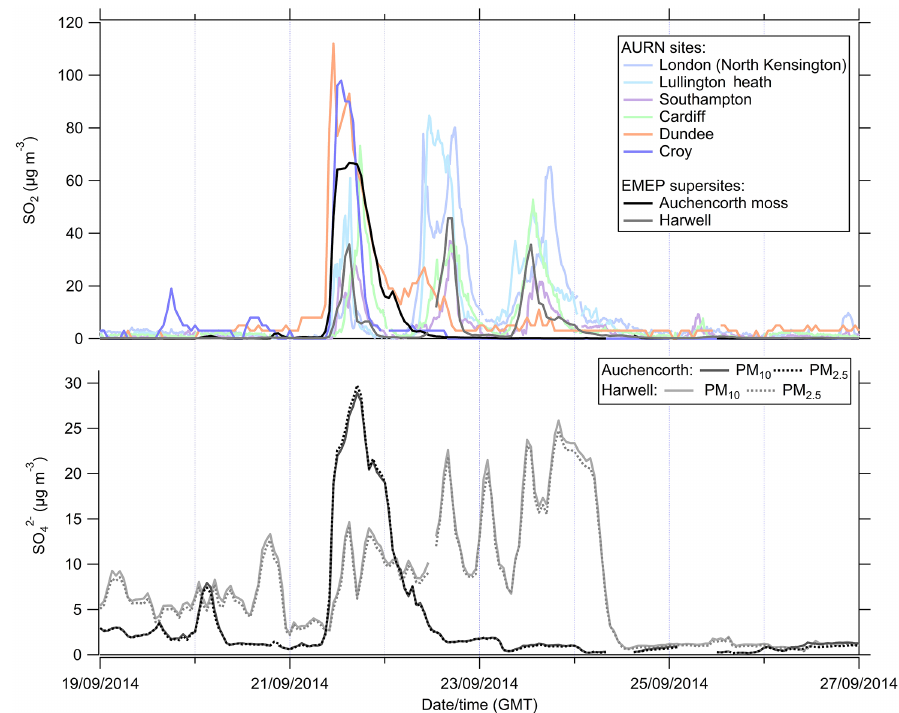
Figure 2. Time series of SO 2 hourly measurements made at six AURN sites in the UK and the two UK EMEP supersite measurements of SO 2 and PM 10 / 2 . 5 SO 2 − . (Note: SO 2 at Auchencorth Moss is underestimated between 11:00 and 22:00 (GMT) on 21 September 2014.) 4